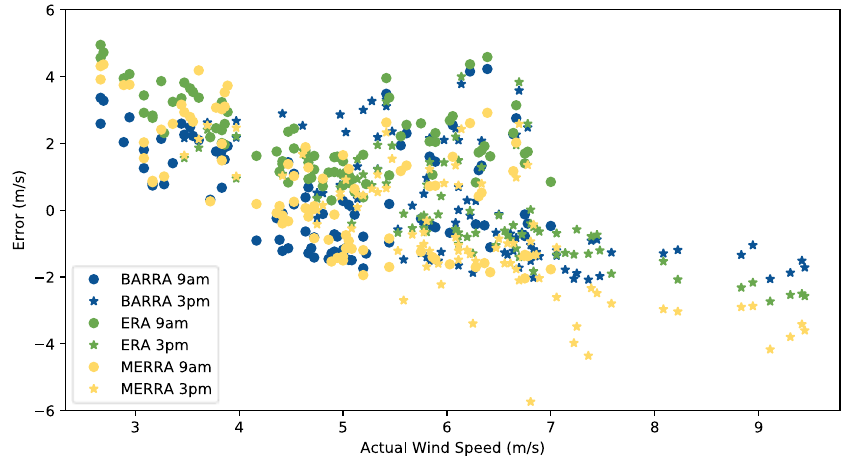
Figure 10. Error in 10 m wind speed predicted using each dataset against actual 10 m wind speed measured by Bureau of Meteorology weather stations.